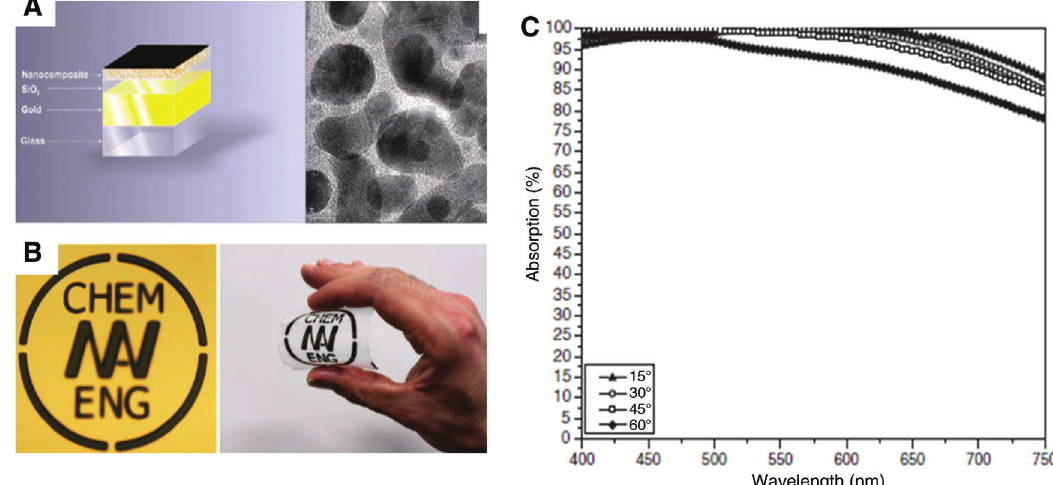
Figure 21: (A) Geometry of the sample studied by Elbahri and coworkers [49]. The structure is composed of (from bottom to the top) a glass substrate coated with an optically thick (100 nm) Au film followed by a thin (25 nm) dielectric layer (SiO ) acting as the spacer layer and at 2 the very top, a thin (20 nm) nearly percolated film of nanocomposite (Au/SiO ).The left panel illustrates that the whole structure resides 2 on a glass substrate; the right panel shows a top-view TEM image of the nanocomposite film. (B) The perfect absorber (blackbody) can be coated via a mask either on gold-coated glass (left) or on flexible polymer foil (right). (C) Absorption spectra of the perfect absorber shown in (A) and (B) with TM polarization at different angles of incidence. Reprinted with permission from Adv. Mater., vol. 23, pp. 5410–4, 2011. Copyright 2011 John Wiley and